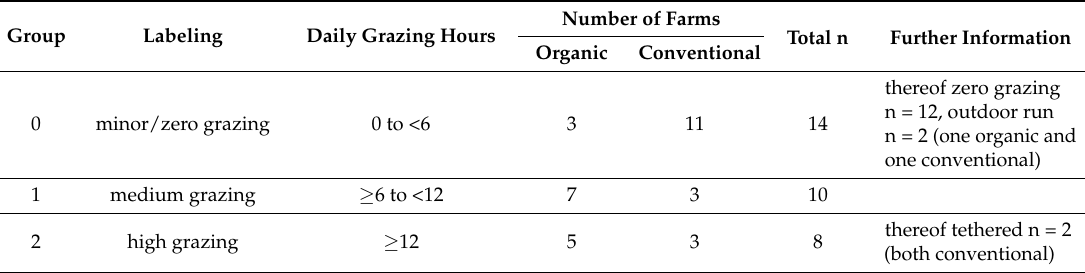
Table 1. Overview of group